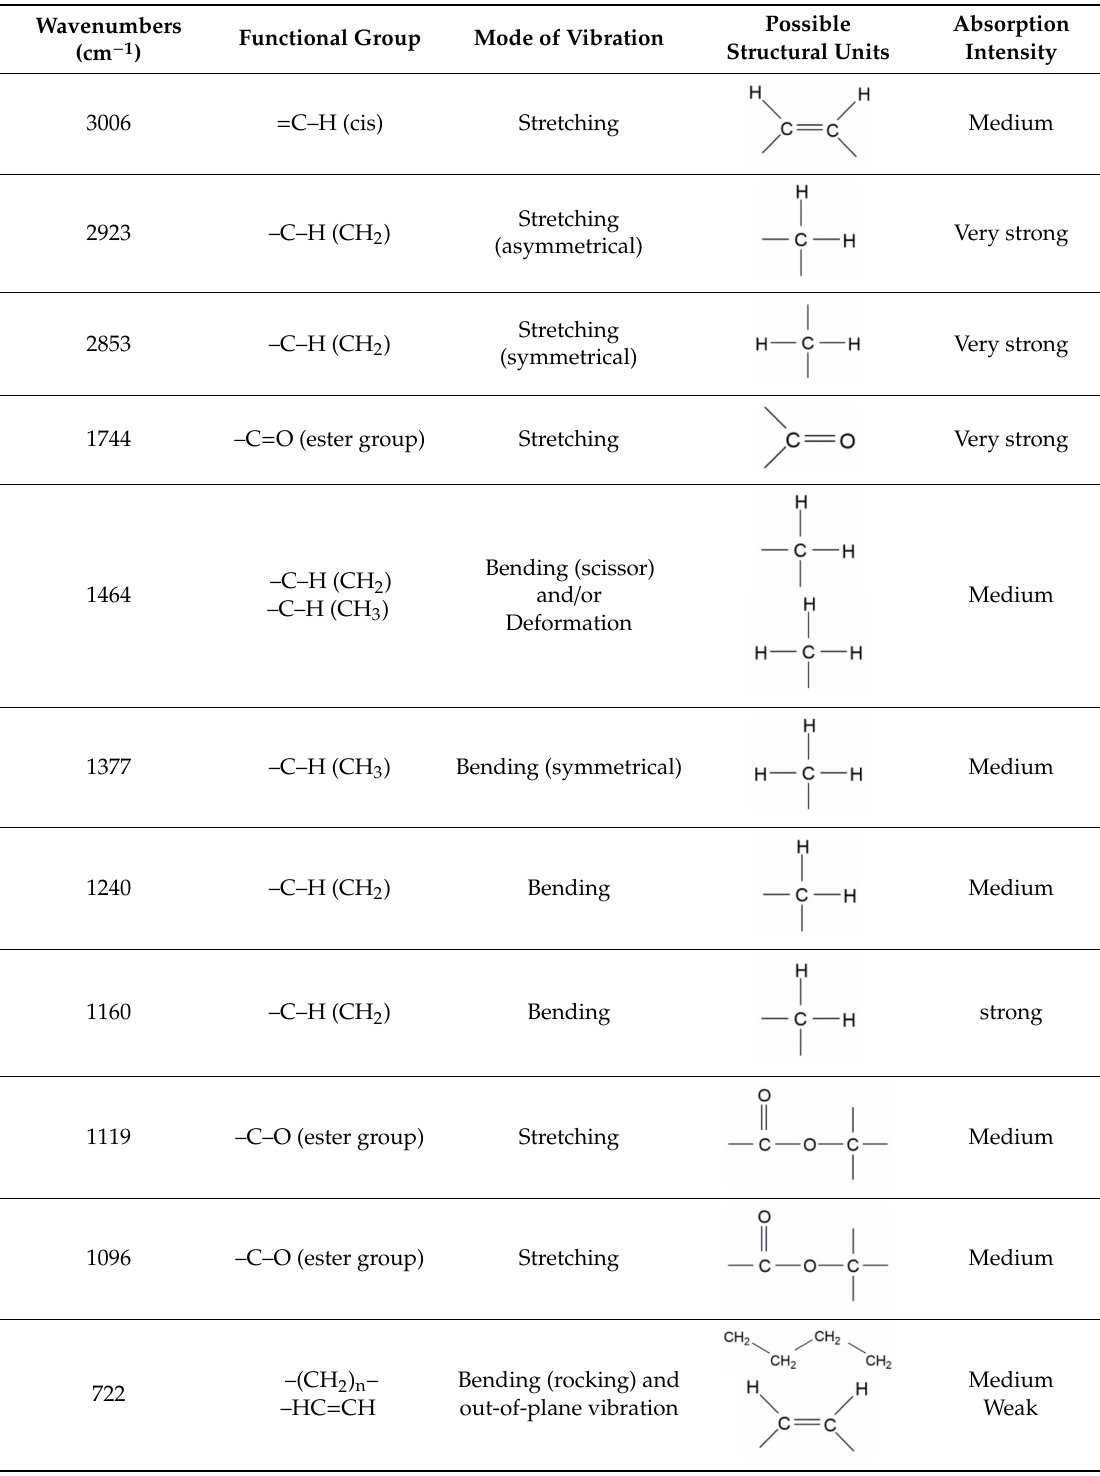
Table 1. Functional groups in the edible oils and impact on the Fourier transform infrared (FTIR) spectrum: wavenumber, functional group, and mode of vibration